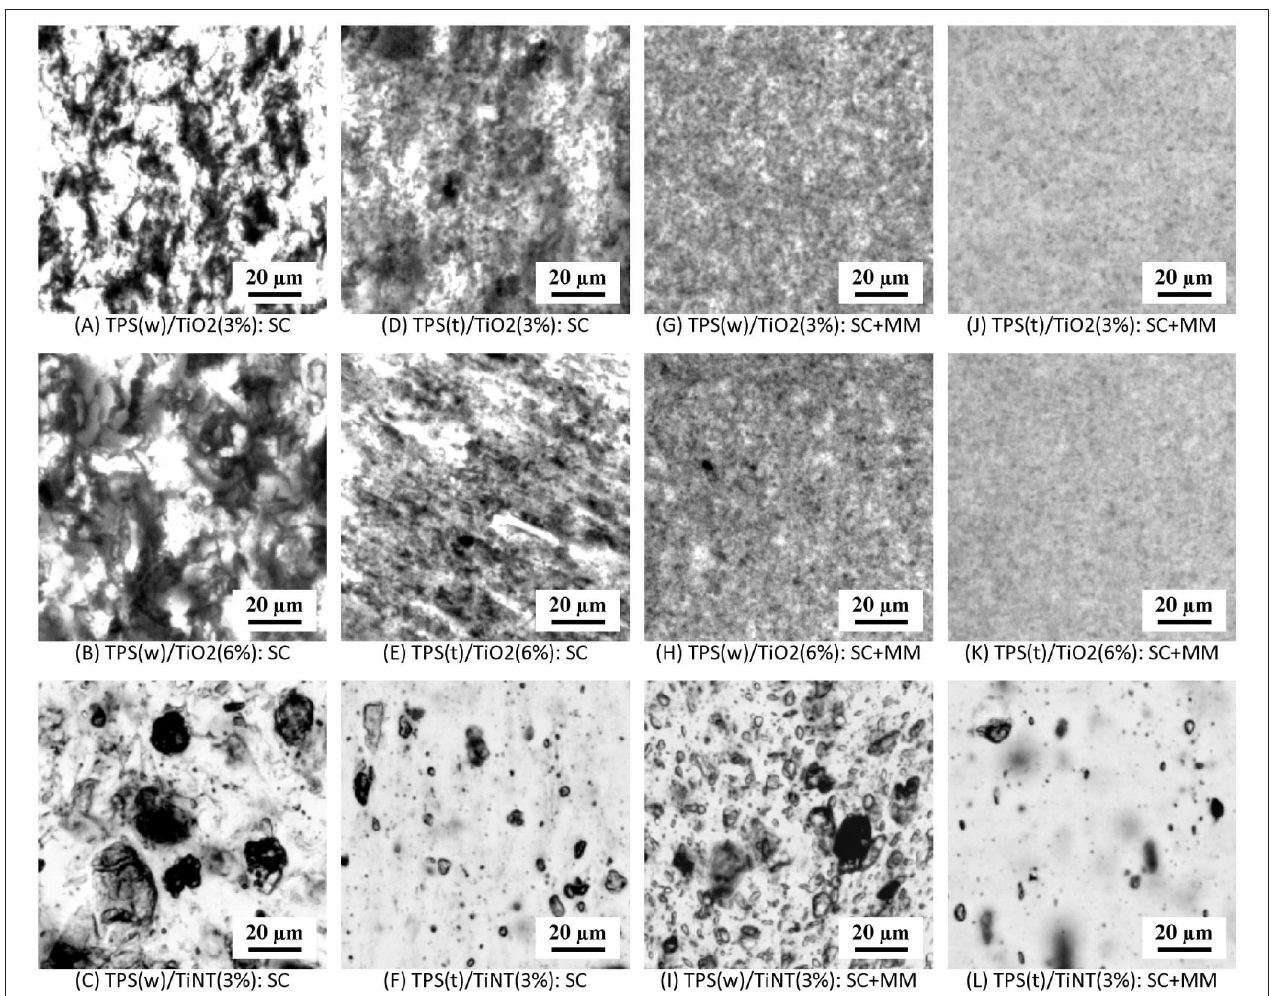
FIGURE 1 | LM micrographs showing the dispersion of filler in TPS/TiX composites: (A–C) wheat starch composites after solution casting, (D–F) tapioca starch composites after solution casting, (G–I) wheat starch composites after solution casting and melt-mixing, and (J–L) tapioca starch composites after solution casting and melt